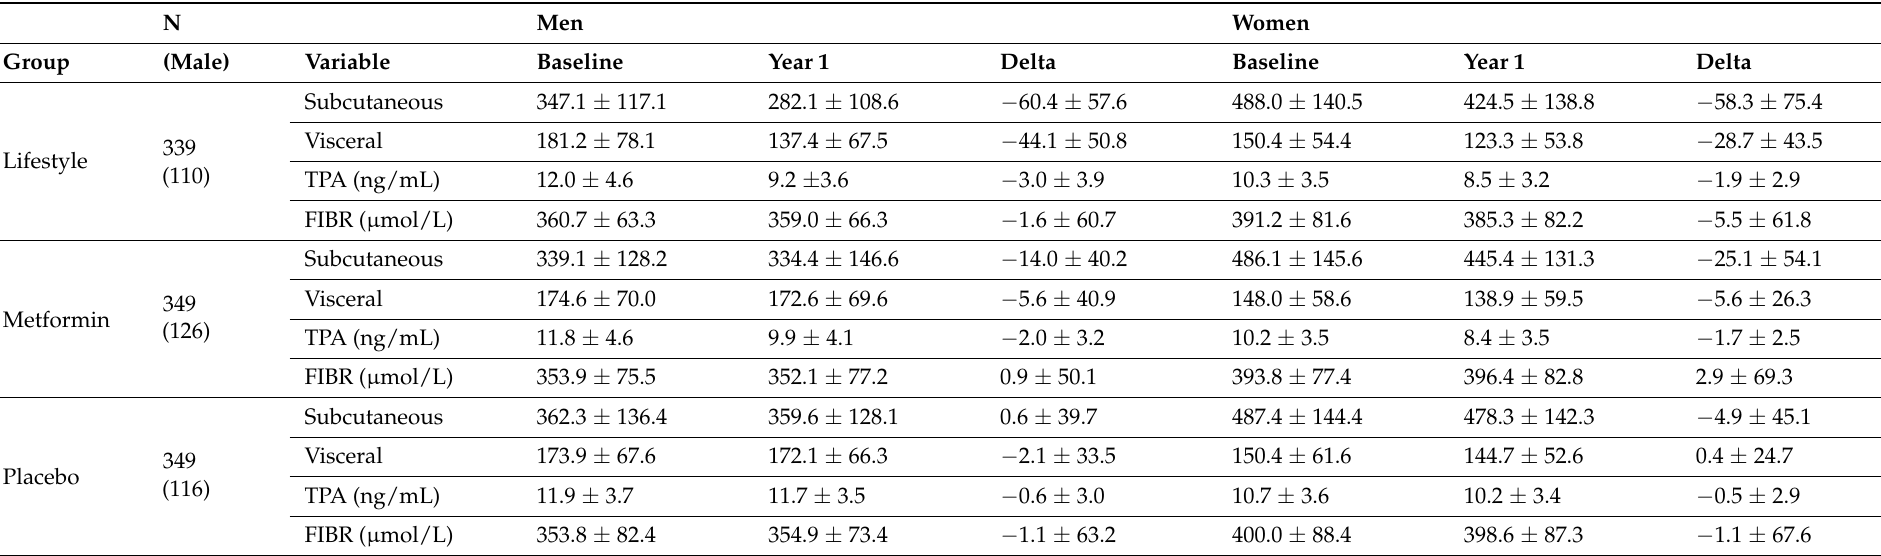
Table 1. Amounts of subcutaneous and visceral adipose tissues and levels of TPA and FIBR in the diabetes prevention program participants. Men